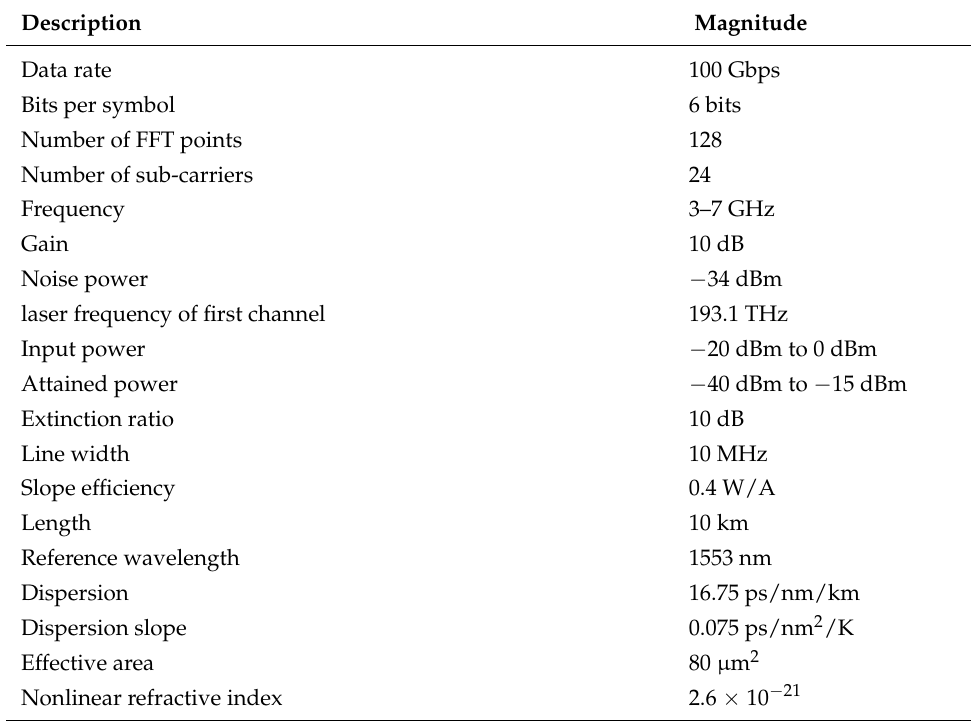
Table 1. Description of parameters used for simulation